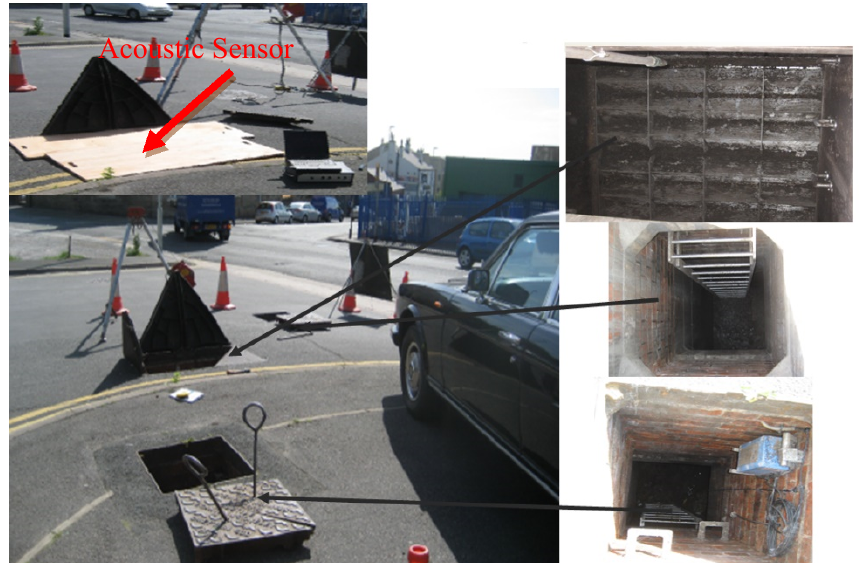
Figure 7. Phase 1: Field trial site 2 in West Yorkshire.